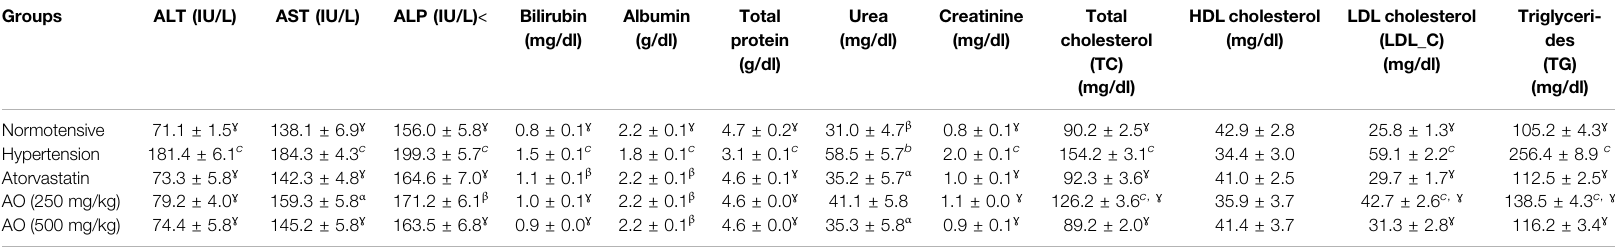
TABLE 6 | Effect of administration of Alpinia of fi cinarum on serum biochemical parameters in chronic obesogenic diet-fed hypertensive rats.